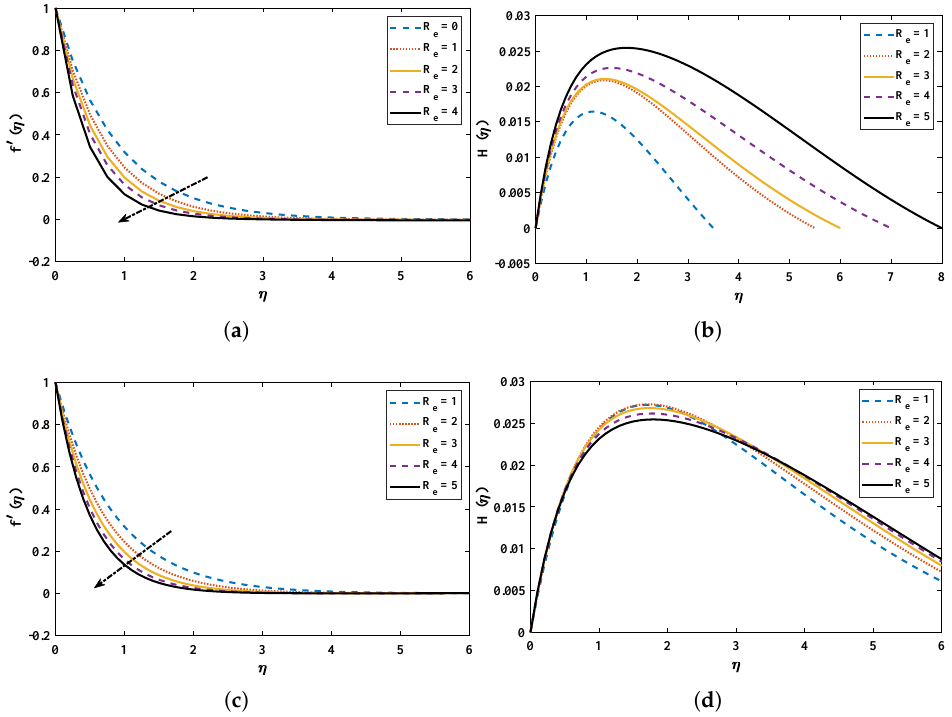
Figure 9. Effect of an increase in the Reynolds number on f (cid:48) and H of the fluid with ( a , b ) isothermal boundary conditions and ( c , d ) isoflux boundary